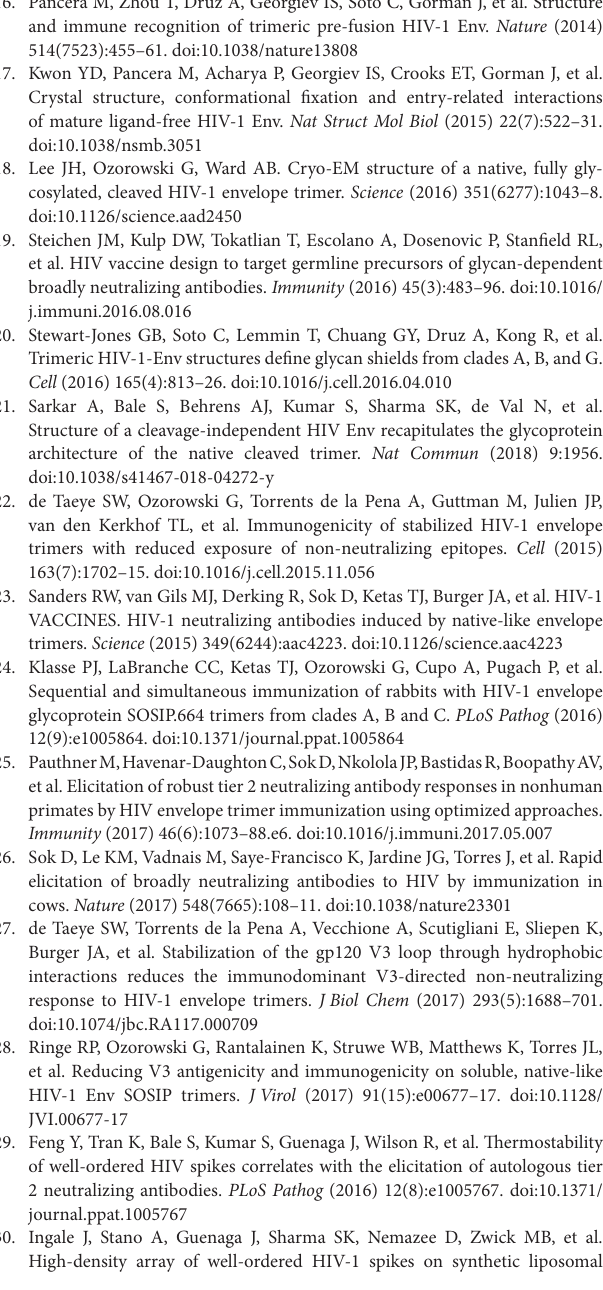
TaBle s1 | Library of glycan structures identified on BG505 NFL trimers. Structures were identified and verified by ion mobility mass spectrometry and are represented using the Oxford glycan nomenclature as previously described (58). Da, Dalton; Calc, calculated. Ions are explained below the table. TaBle s2 | N-linked glycopeptide compositions of trypsin- and chymotrypsin- digested BG505 NFL trimers produced in CHO-M cells identified by liquid chromatography–electrospray ionization-tandem mass spectrometry. Site, N-glycosylation site; XIC, extracted ion chromatogram; Exp., experimental determined mass (shown as a range when different charge states and/ or different scans were recorded); Calc., calculated mass. All cysteines are carbamidomethylated. Lower case letters in sequence indicate the position of the modification. Table contains data from two analytical replicates per